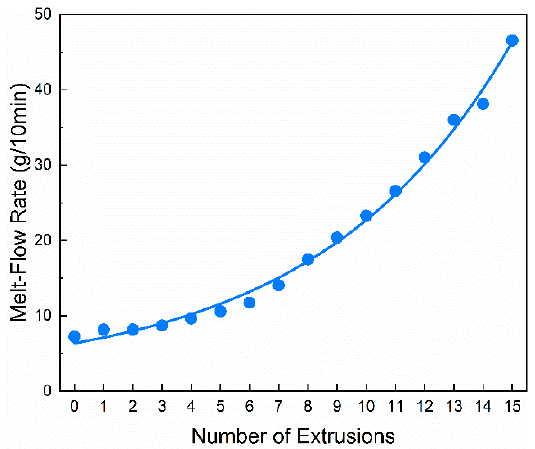
Figure 5. Variations of melt-flow rate (MFR) in PP with different numbers of extrusions.